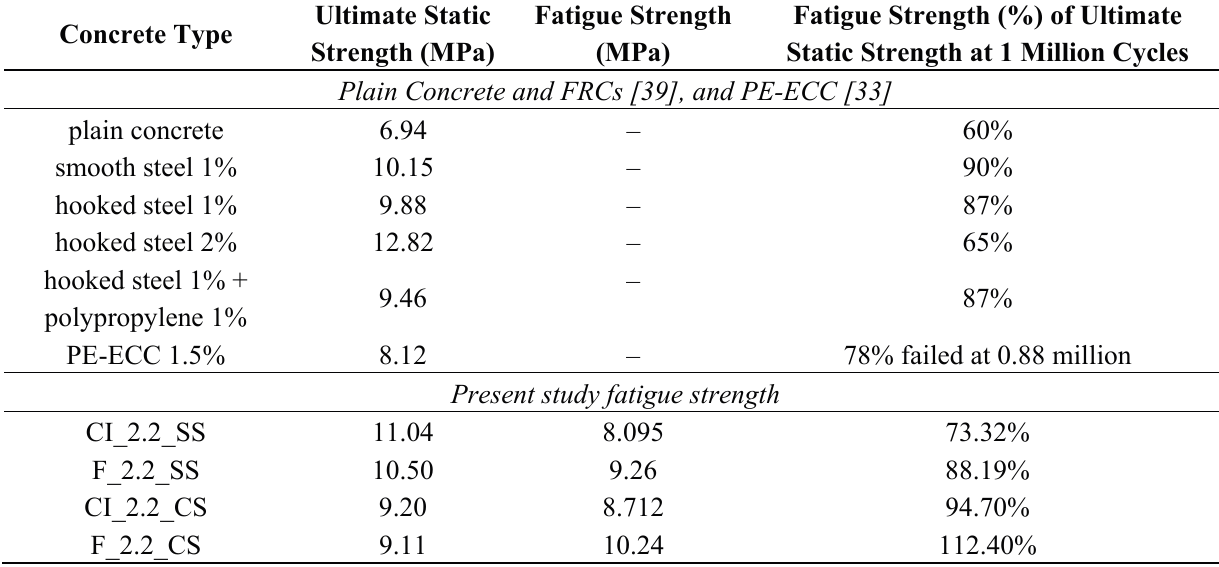
Table 8. Comparison between fatigue strength of plain concrete, fiber reinforced concretes (FRCs) [39], polypropylene engineered cementitious composites (PE-ECC) [33] and present study fly ash (FA)-ECC